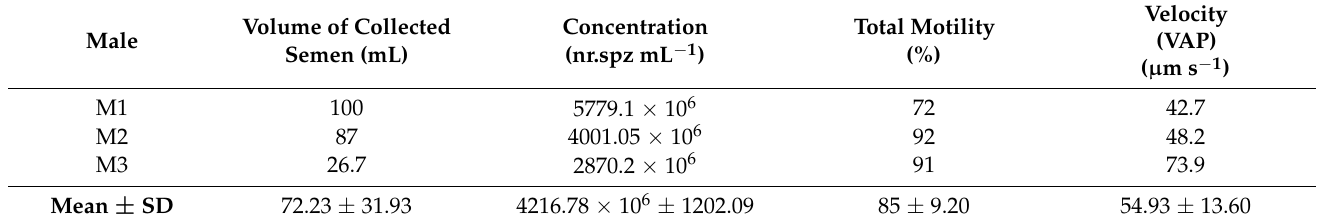
Table 6. Sperm parameters recorded in Russian sturgeon semen samples immediately after